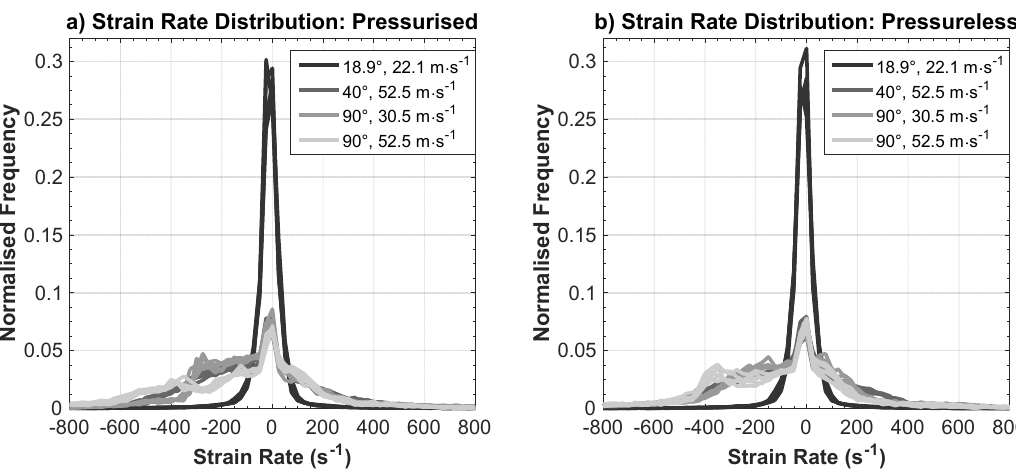
Figure 10. Strain rate distribution during impact for pressurised ( a ) and pressureless ( b ) ball cores.